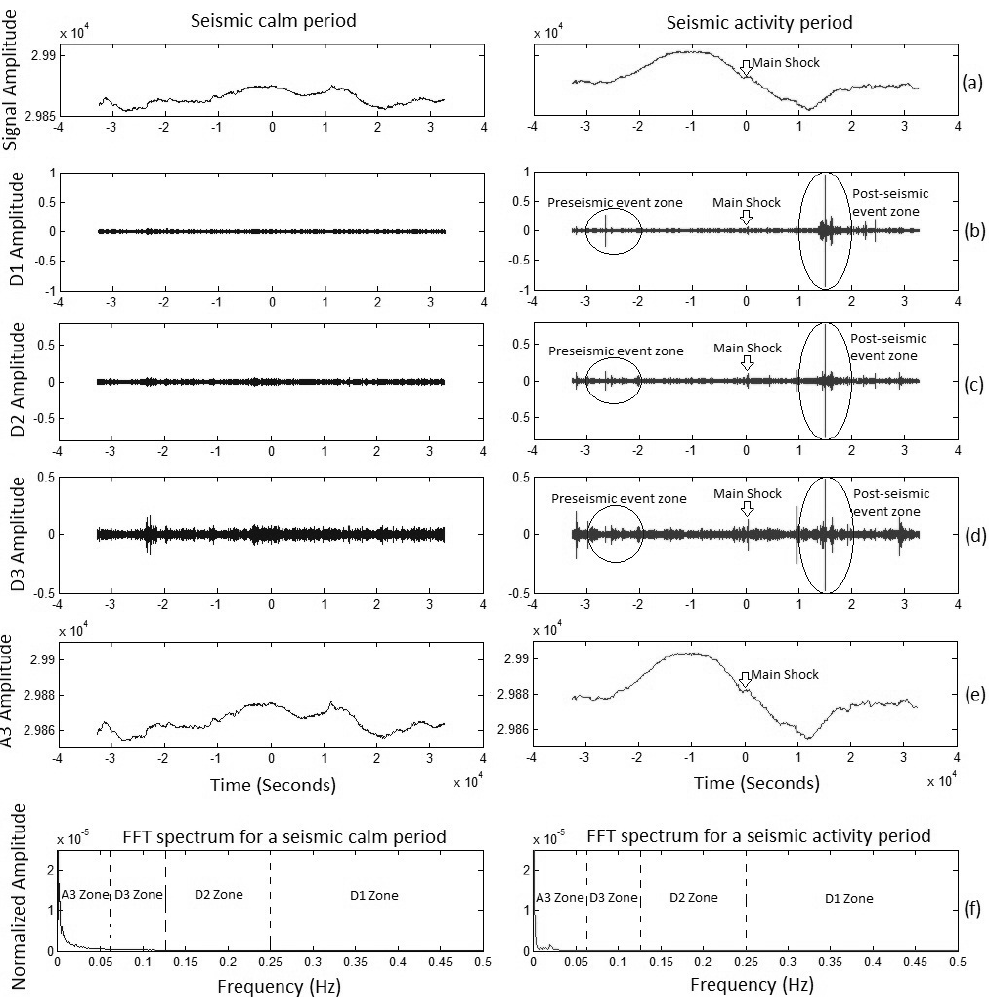
Fig. 2. Comparison between FFT spectrum and DWT time-frequency decomposition analysis; for a seismic calm, and with seismic activity. The main seismic shock is shown with a white arrow.